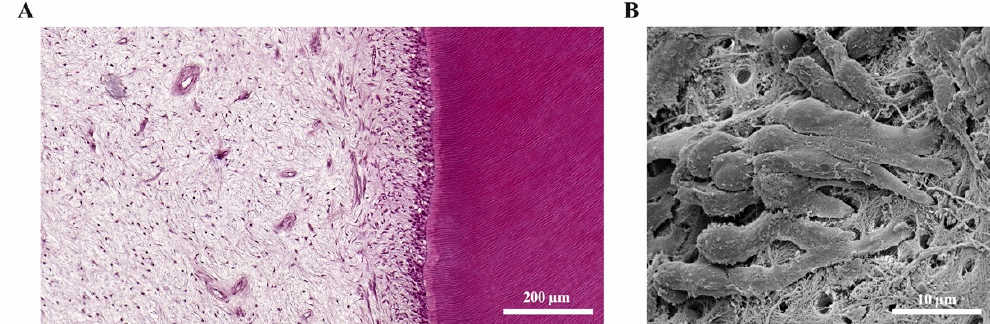
Figure 2. The dental pulp. ( A ) Histology of the dentine-pulp complex (own collection). ( B ) Odontoblast layer depicted by scanning electron microscopy (modified from [12]).